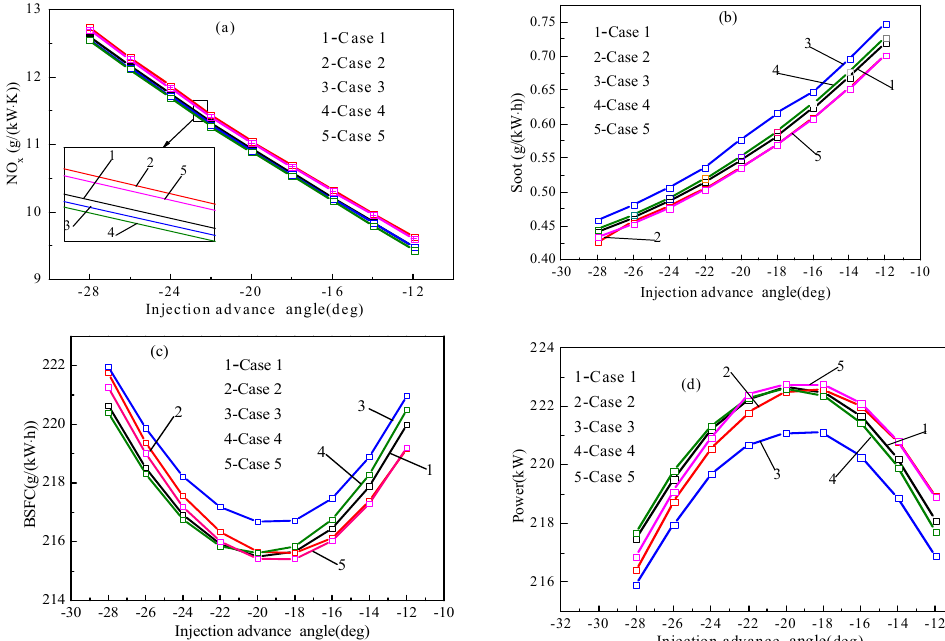
Figure 7. The effects of the injection advance angle on the performance of a diesel engine. ( a ) NO x ; ( b ) Soot; ( c ) BSFC; ( d ) Power.